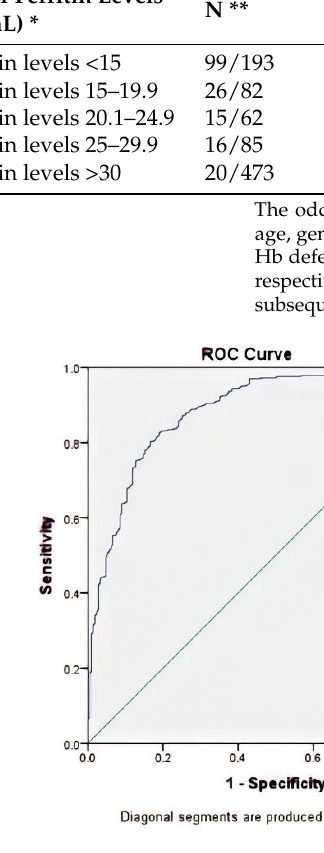
Figure 3. Receiver operating characteristic curve for predicting low iron (defined as ferritin <15 ng/mL or low-Hb deferral) at a subsequent donation attempt based on ferritin levels at any of the